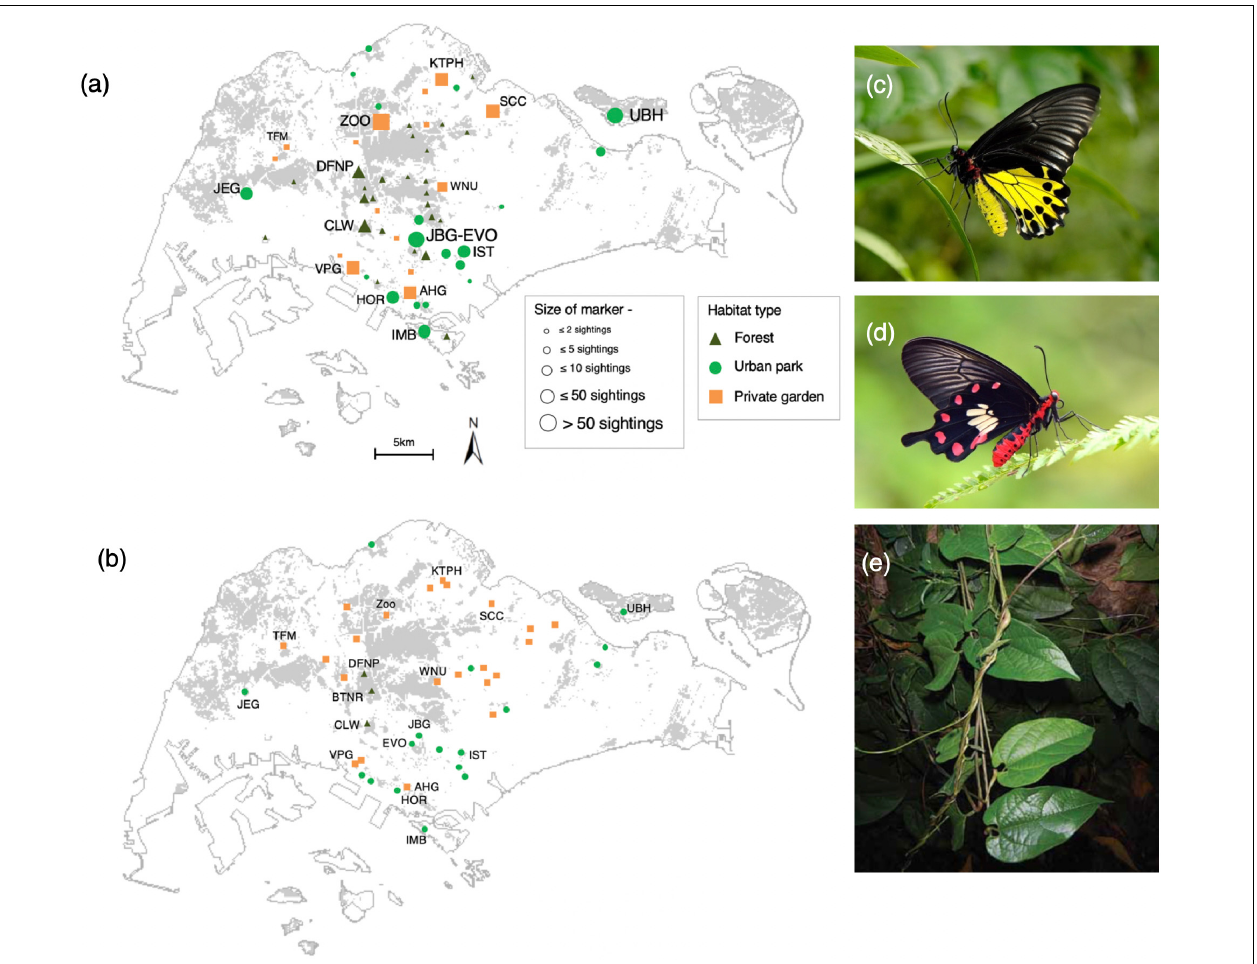
FIGURE 1 | (a) Combined sightings of Common Birdwing (BW) and Common Rose (CR) butterflies, (b) Larval host plant locations across habitat types in Singapore from years 1999 to 2019. Gray areas in the map refer to forested areas. Abbreviations refer to source locations identified by experts (see Supplementary Table 1 for details). (c) Common Birdwing, (d) Common Rose, (e) Aristolochia acuminata larval host plant. Photos (c,d) by Tea Yi Kai, (e) by Amy